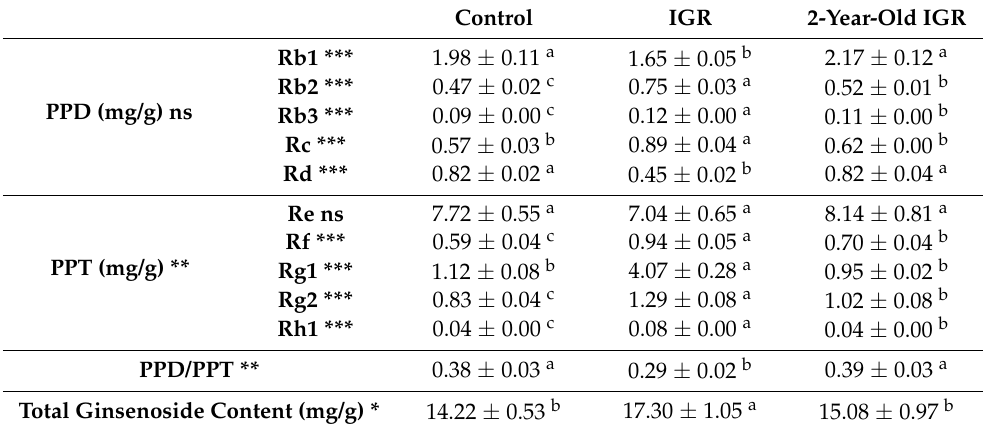
HPLC analysis was performed on control roots, IGRs, and 2 year old IGRs. Values represent the means ± standard error of three independent experiments, each consisting of 20 roots. ns, *, **, ***: non-significant or significant at p ≤ 0.05, 0.01, or 0.001 determined by ANOVA. Different letters within each column represent significant differences ( p ≤ 0.05) based on Duncan’s multiple comparison test. IGR, in vitro-grown root; HPLC, high- performance liquid chromatography; PPD, protopanaxadiol; PPT,